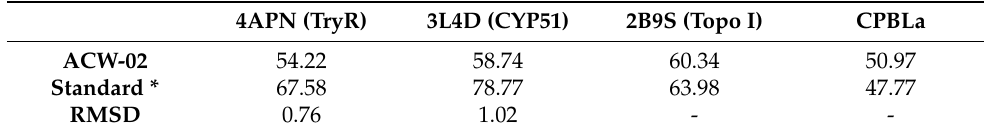
Table 4. Molecular docking results of ACW-02 against potential antileishmanial targets.